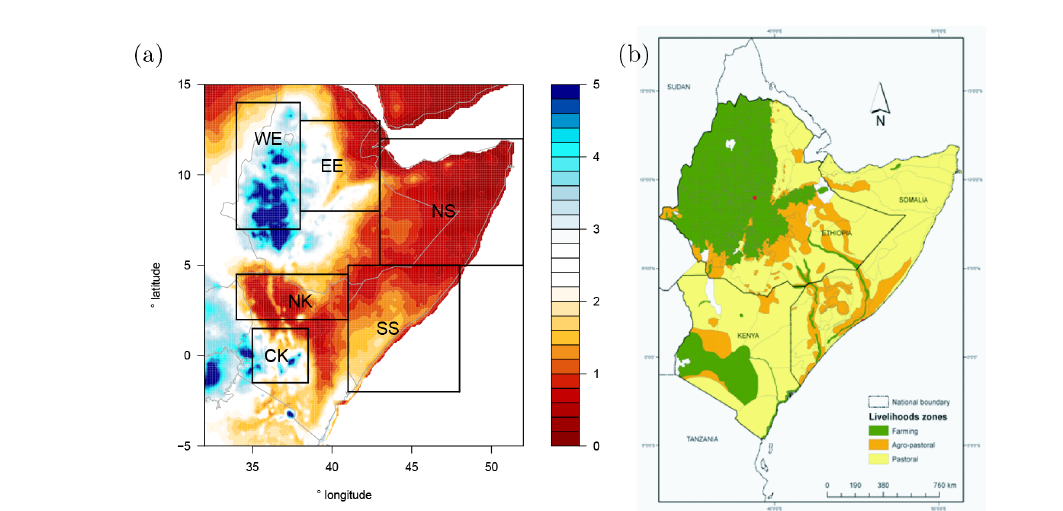
Figure 1. (a) Annual mean precipitation [mm/d] and the six study regions. Note that only land values are used. (b) Livelihood zones, which were also used to define the study regions. Reprinted from Pricope et al. (2013) with permission from